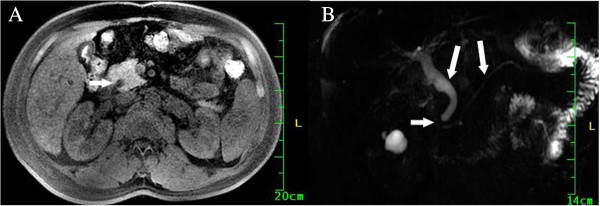
Magnetic resonance imaging findings on 22 February 2011. (A) Short inversion time inversion recovery image, showing a mildly dilated common bile duct. Heterogeneous isointense areas (white arrow) were observed in the distal portion of the common bile duct, suggesting common bile duct stones. (B) Magnetic resonance cholangiopancreatography, showing mild obstruction at the duodenal ampulla (short white arrow). The common bile duct and pancreatic duct were slightly dilated (long white arrows).